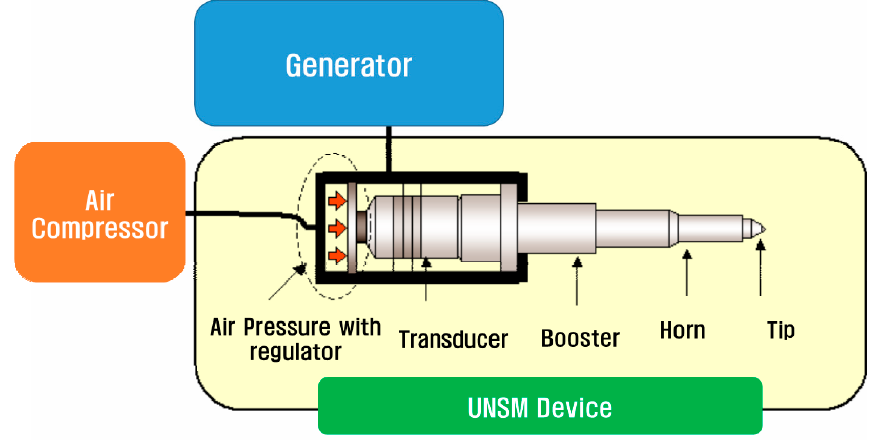
Figure 1. Ultrasonic fatigue tester.